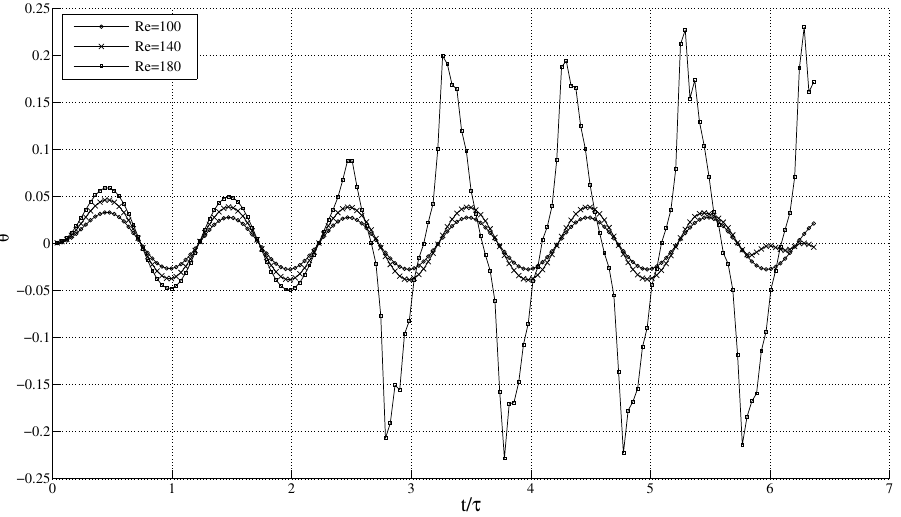
Figure 10. Variation of azimuthal velocity with time for different Re for the varying angular speed case. For a geometry with radii ratio η = 0.7 (narrow gap) and η = 0.4 (wide gap), we have studied the dependence of the critical Reynolds number (Re cr ) on the dimensionless frequency